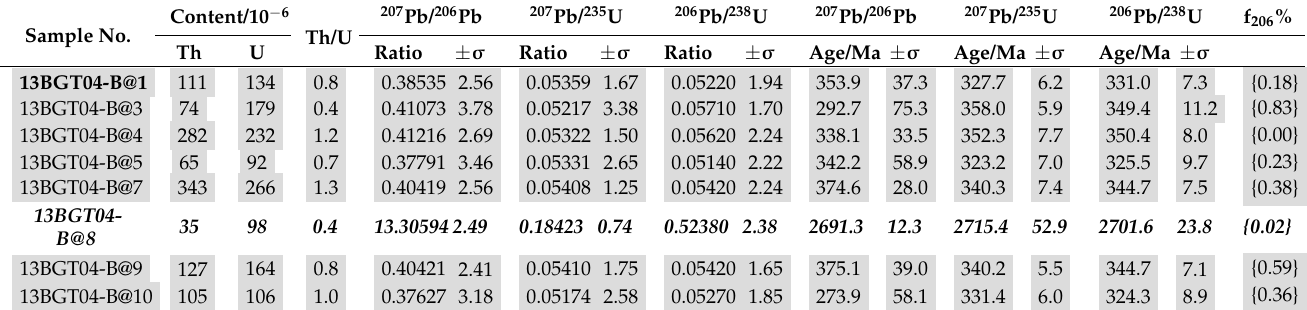
Table 1. SIMS zircon U-Pb ages of the tuffaceous siltstone enclaves in the Baogutu reduced Cu porphyry-type deposit, West Junggar, Northwest